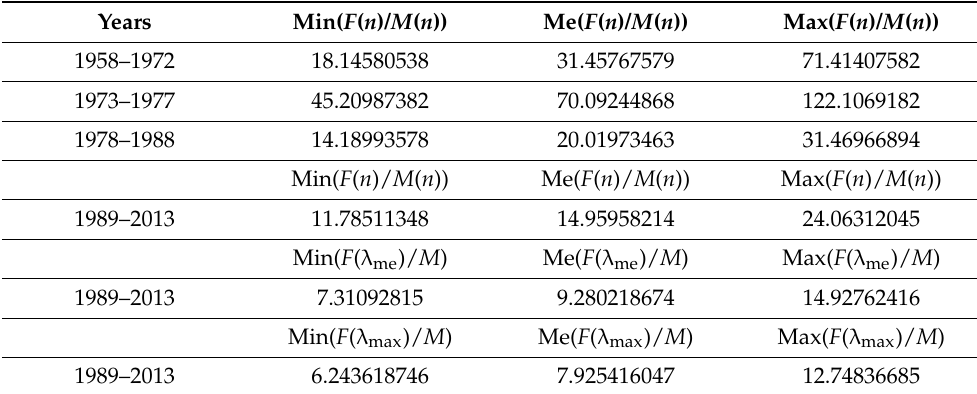
Table 2. Descriptive statistics of the distribution of the sex ratio in the population.